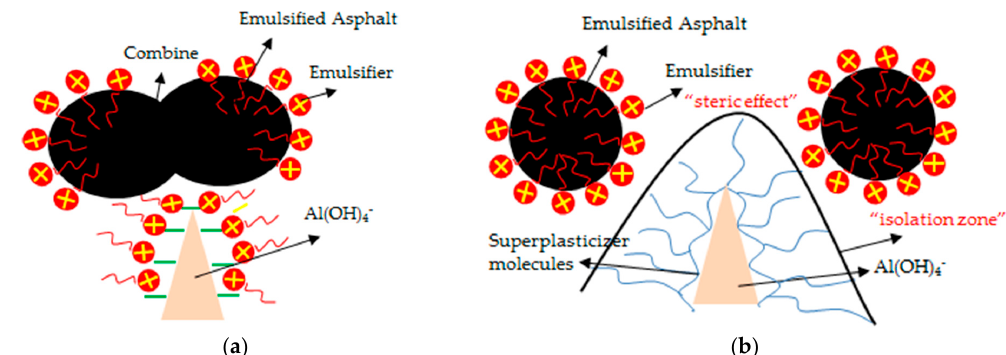
Figure 16. Schematic illustration of competitive adsorption of superplasticizer molecules and asphalt particles ( a ) Without superplasticizer, ( b ) With superplasticizer.